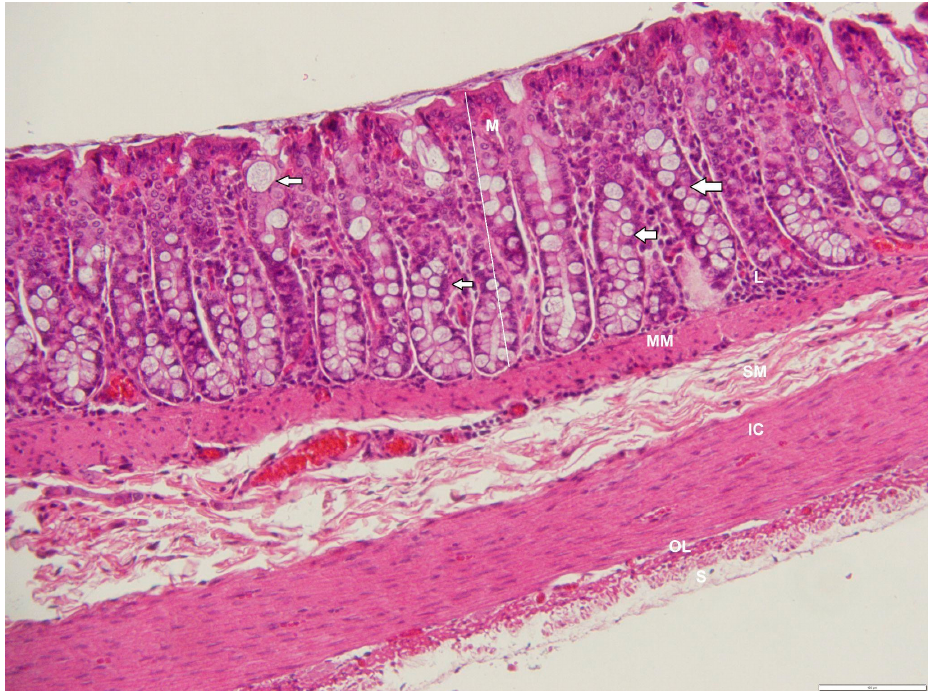
Figure 11. Photomicrograph of a cross-section through the ileum of an adult male D. leporina , showing numerous goblet cells in the mucosa (arrows). H&Ex200. M—mucosa; MM—muscularis-mucosa; L—lymphocyte infiltration; SM—submucosa; IC—inner circular layer; OL—outer longitudinal layer; S—serosa.